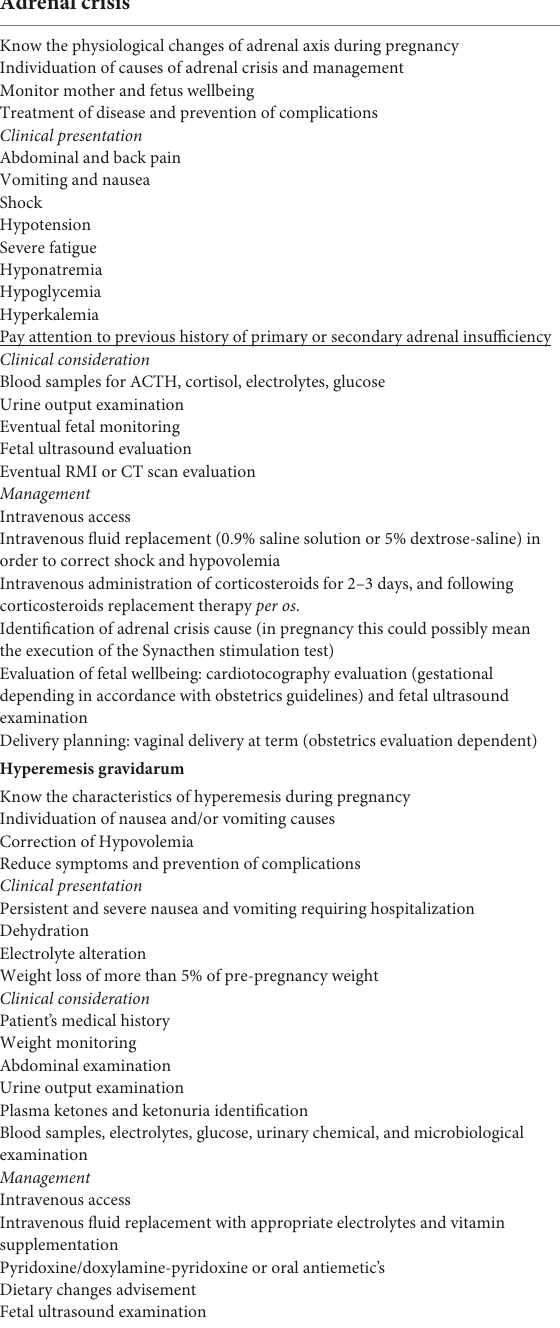
TABLE 1 Characteristics and management of AD in pregnancy and hyperemesis